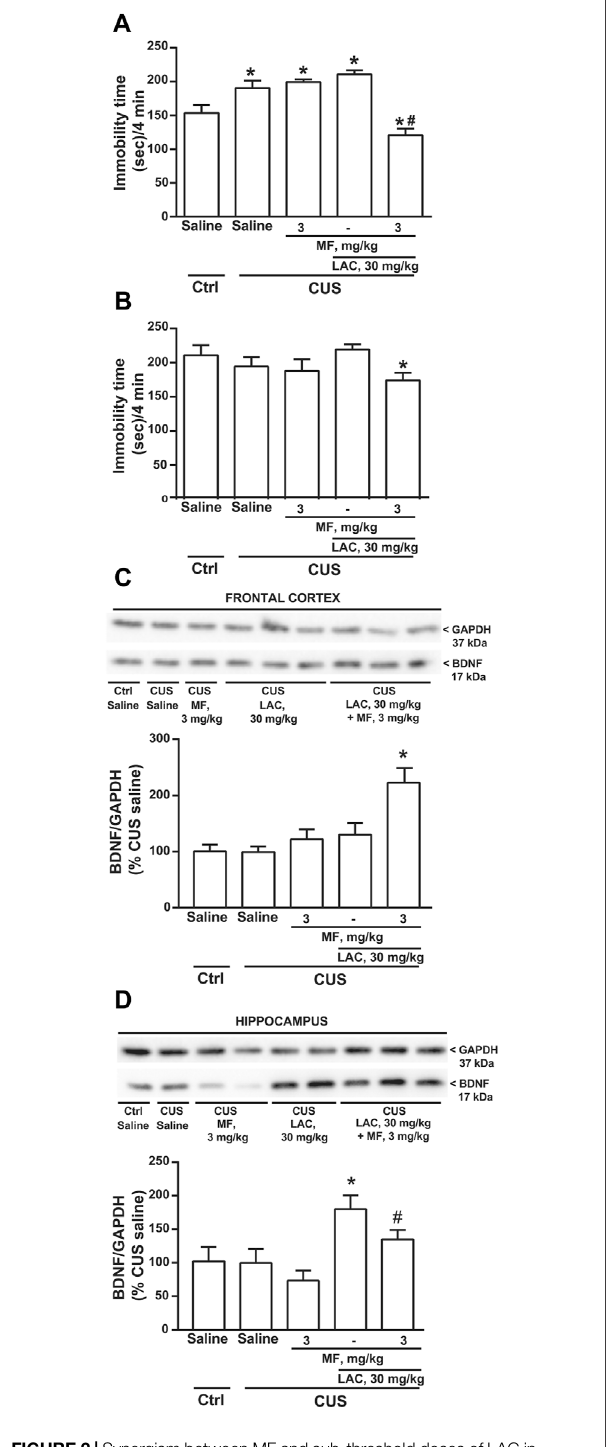
FIGURE 2 | Synergism between MF and sub-threshold doses of LAC in reducing the immobility time and enhancing BDNF expression in mice subjected to CUS. Immobility time in the forced swim test in unstressed (Ctrl) mice treated i.p. for 3 days with saline and CUS mice treated i.p. for 3 days with saline, MF (3 mg/kg), LAC (30 mg/kg) or LAC + MF is show in (A) . BDNFproteinlevelsinthefrontalcortexadhippocampusareshownin (C) and